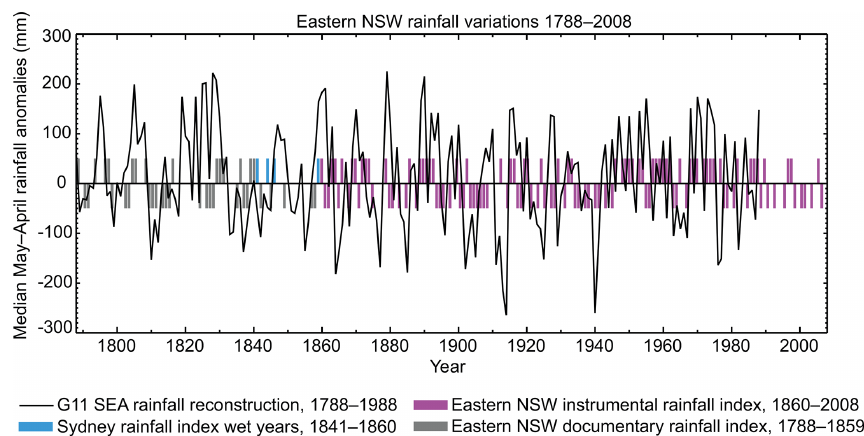
Figure 12. Wet and dry years for eastern New South Wales (Australia) identified using the nine-station network (1860–2008CE, purple) and a documentary index (1788–1860CE, grey). The median rainfall reconstruction (1788–1988) from Gergis et al. (2012) is also plotted as anomalies (mm) relative to a 1900–1988 base period. Note that 1841, 1844, 1846, and 1859 have been classified as wet, in accordance with a rainfall index derived from observations in the Sydney region (blue). Adapted from Gergis and Ashcroft